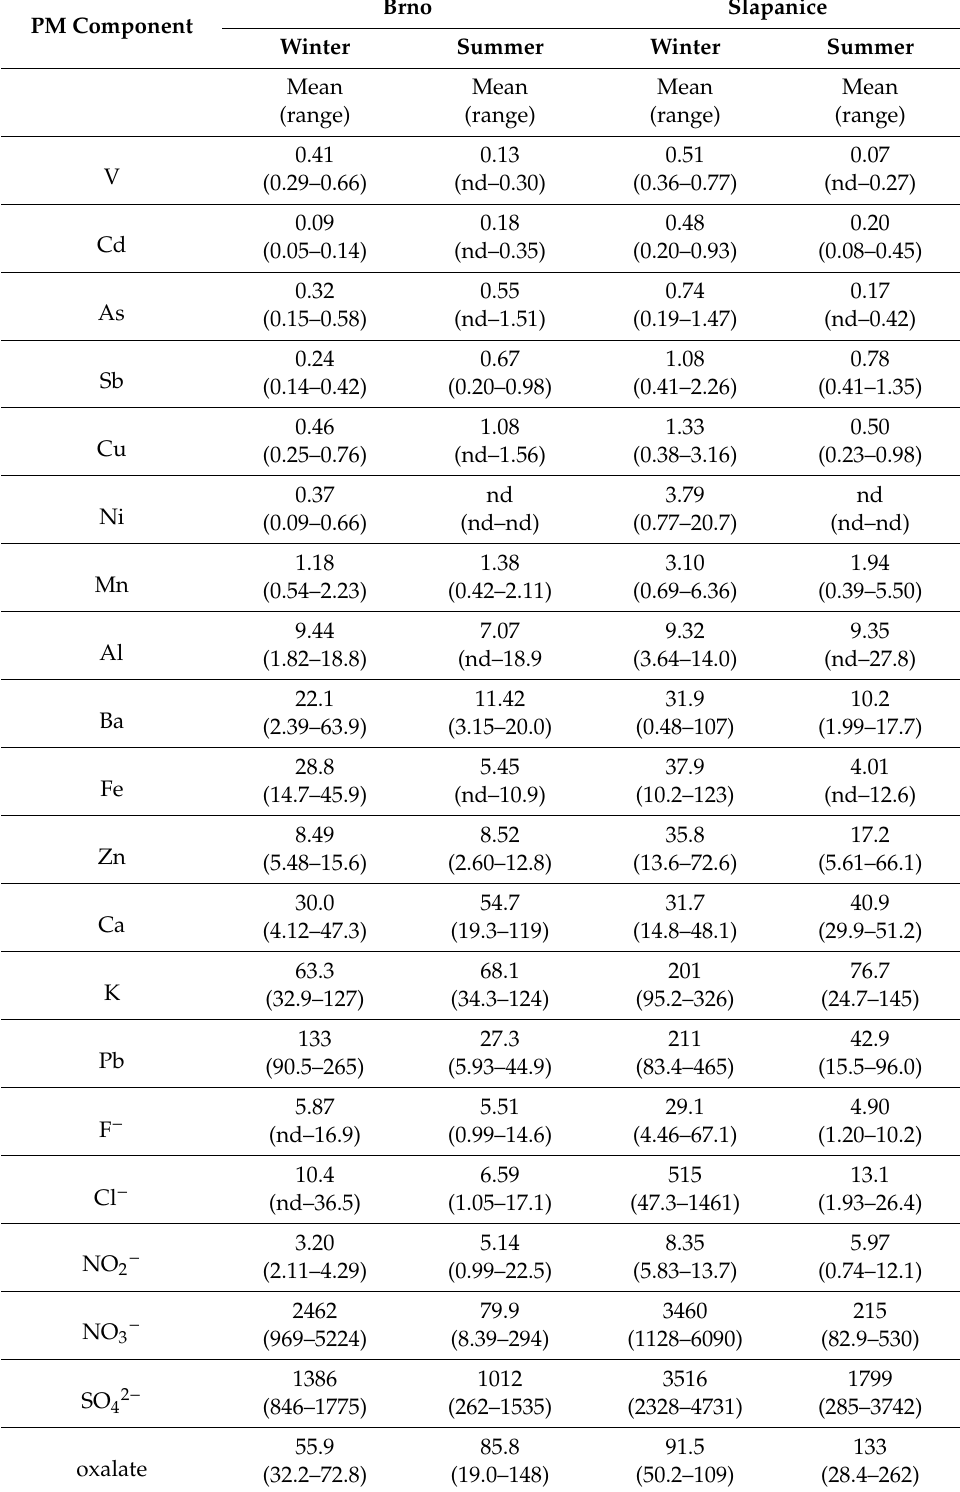
Table 3. Summary of concentrations of elements and water-soluble ions (ng m − 3 ) in PM 1 aerosols collected during the winter and summer campaigns in Brno and Šlapanice in